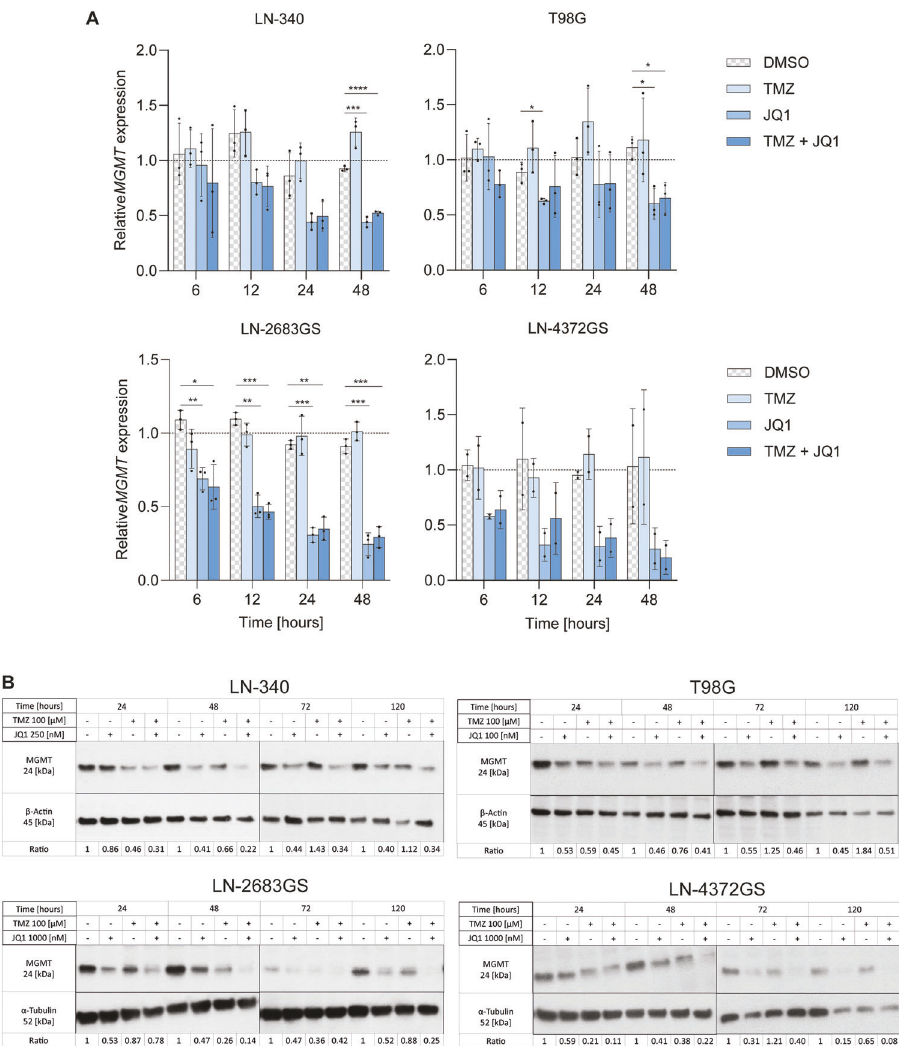
Fig. 2 BET protein inhibition reduces MGMT expression in GBM. A qRT-PCR analysis of relative MGMT gene expression at 6, 12, 24 and 48 h after treatment with [100 μ M] TMZ and JQ1 at the following concentrations: [250 nM] for LN-340, [100 nM] for T98G, and [1000 nM] for the sphere lines LN-2683GS and LN-4372GS. Each data point represents an independent experiment. Data were normalized to the respective DMSO treatment for each time point (baseline). Adjusted p -values ( p ) were determined by Dunnett ’ s multiple comparisons test following two- way ANOVA using Geisser-Greenhouse correction for variance heterogeneity and including interaction between time and treatment. Error bars are SD. *( p ≤ 0.05), **( P ≤ 0.01), ***( P ≤ 0.001). B Protein expression analysis of MGMT, β -Actin and α -Tubulin by western blot, 24, 48, 72 and 120 h after treatment. One of three representative biological replicates is shown. The quanti fi cation of three replicates is shown in Supplemental Fig. S2B. Full length western blots are available in Supplemental